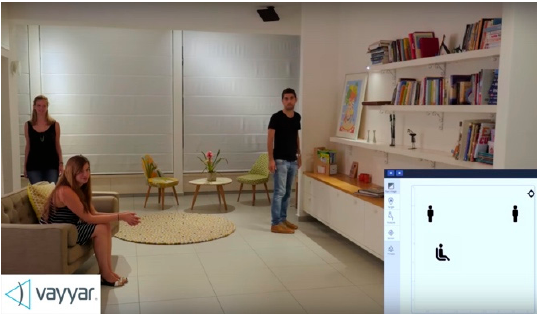
Figure 5. Vayyar UWB-solution for tracking location, posture, etc. [Source: Vayyar].